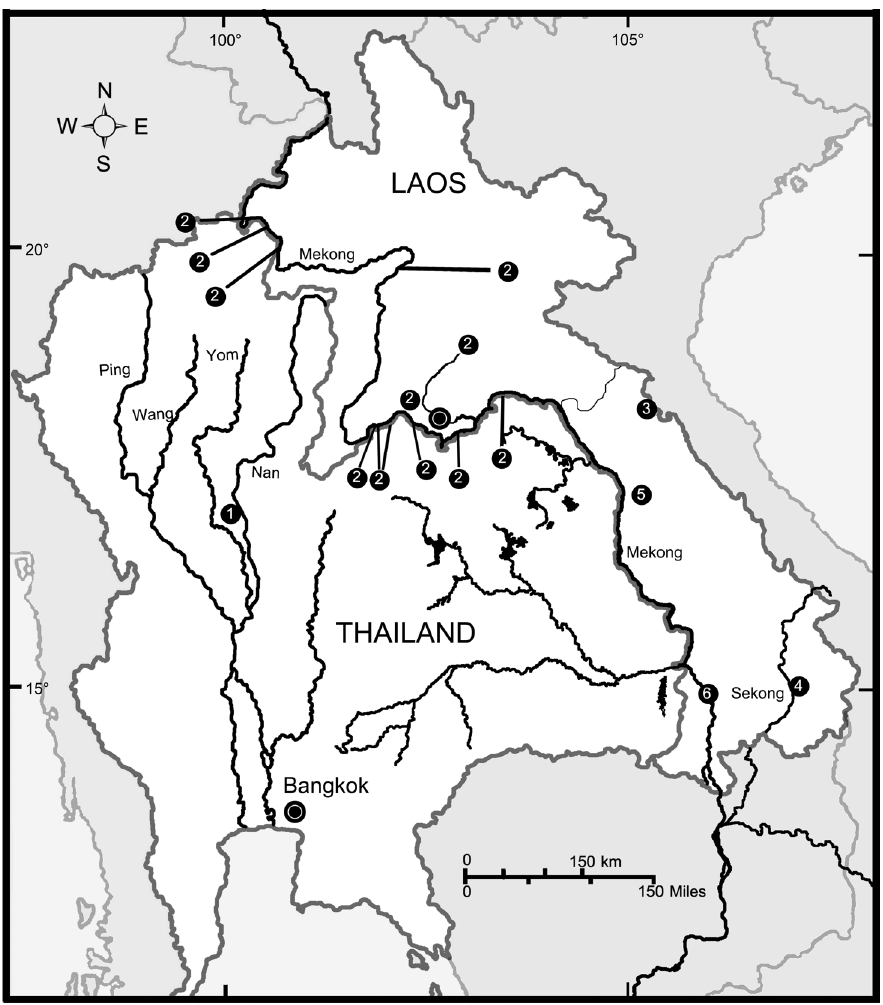
Figure 1. Distribution map of the new Glyphidrilus species from Thailand and Laos. Numbers in the circles refer to localities of the new species. 1 Glyphidrilus nanensis sp. n. 2 Glyphidrilus